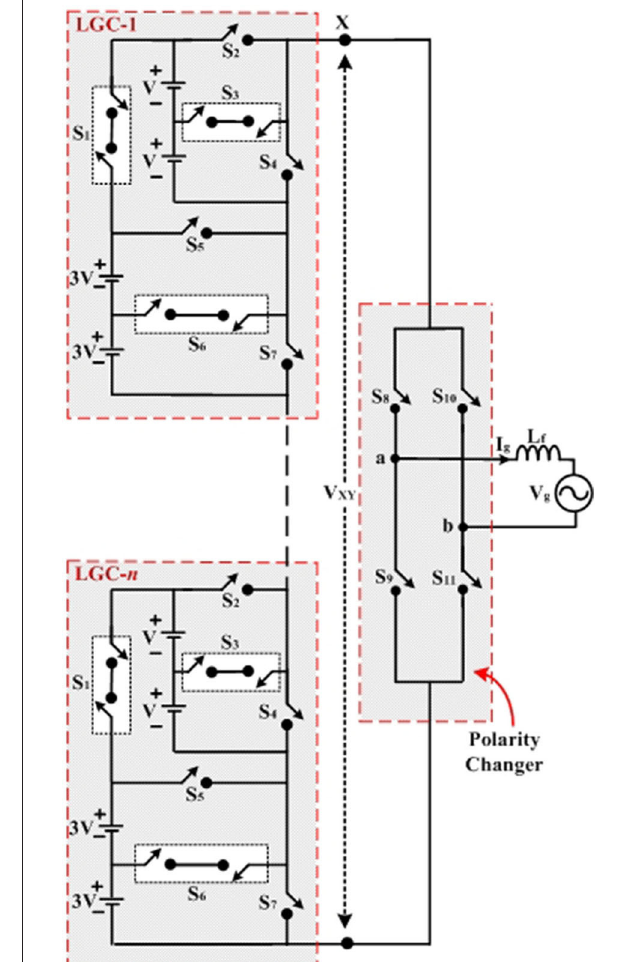
FIGURE 7 | The possible extension of 1- φ seventeen level inverter to n -level.